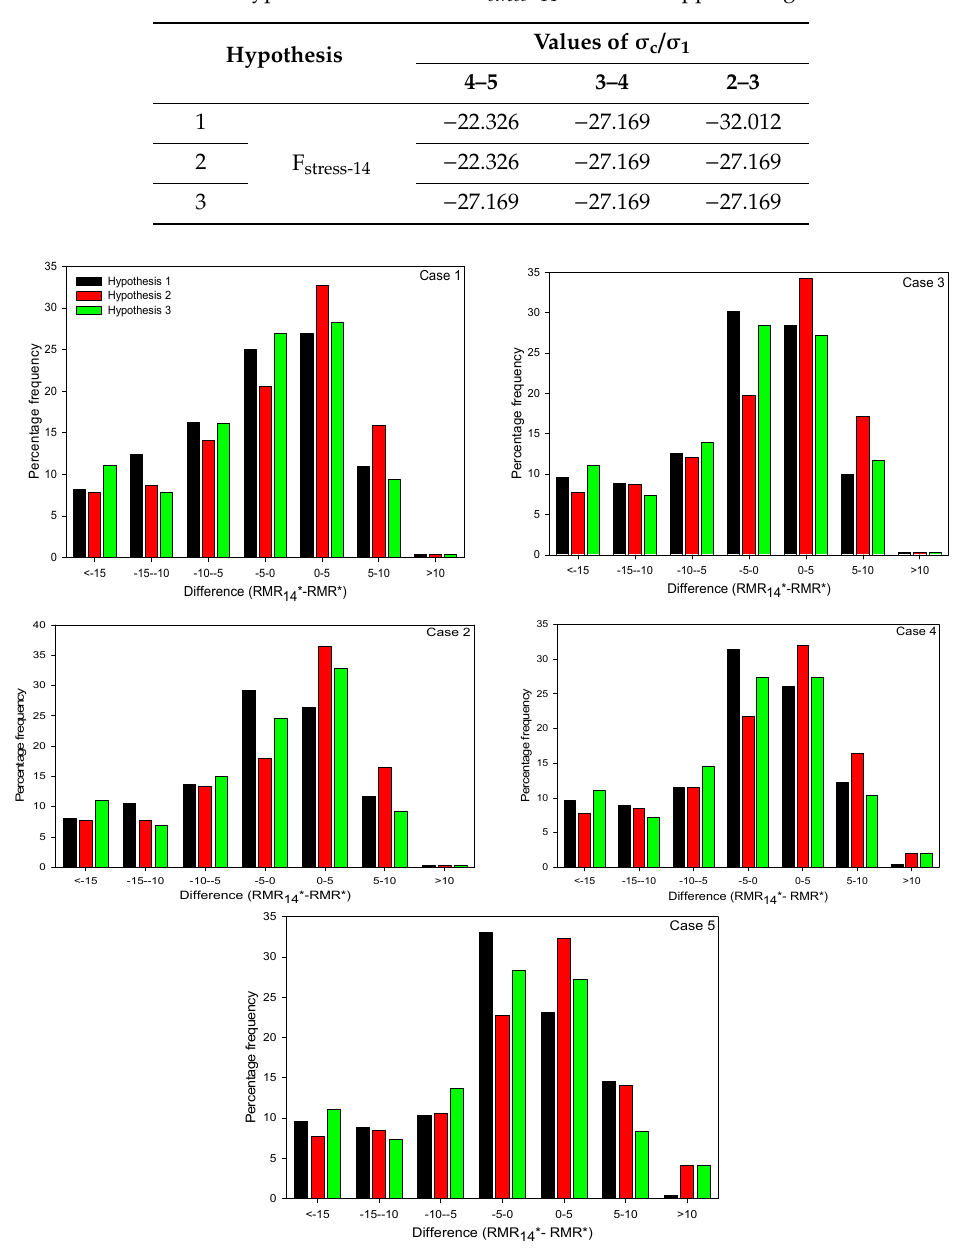
Table 8. Hypothesis used for the F stress − 14 in tunnel support design.